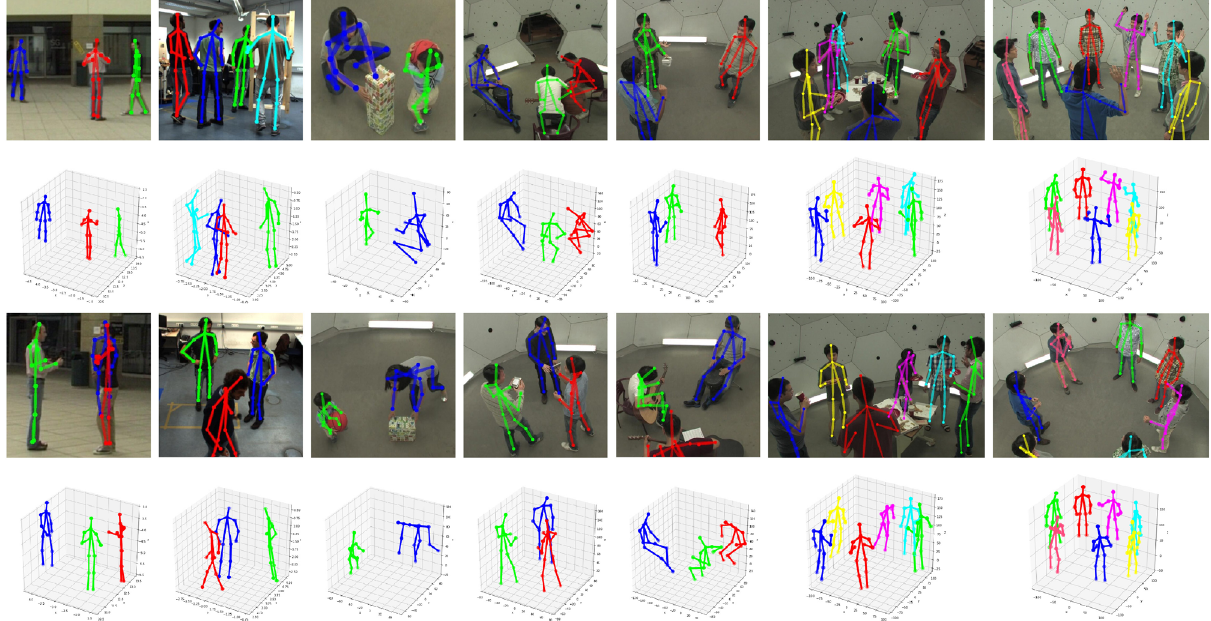
Fig. 5 Illustrative results from our method on Campus, Shelf, and Panoptic